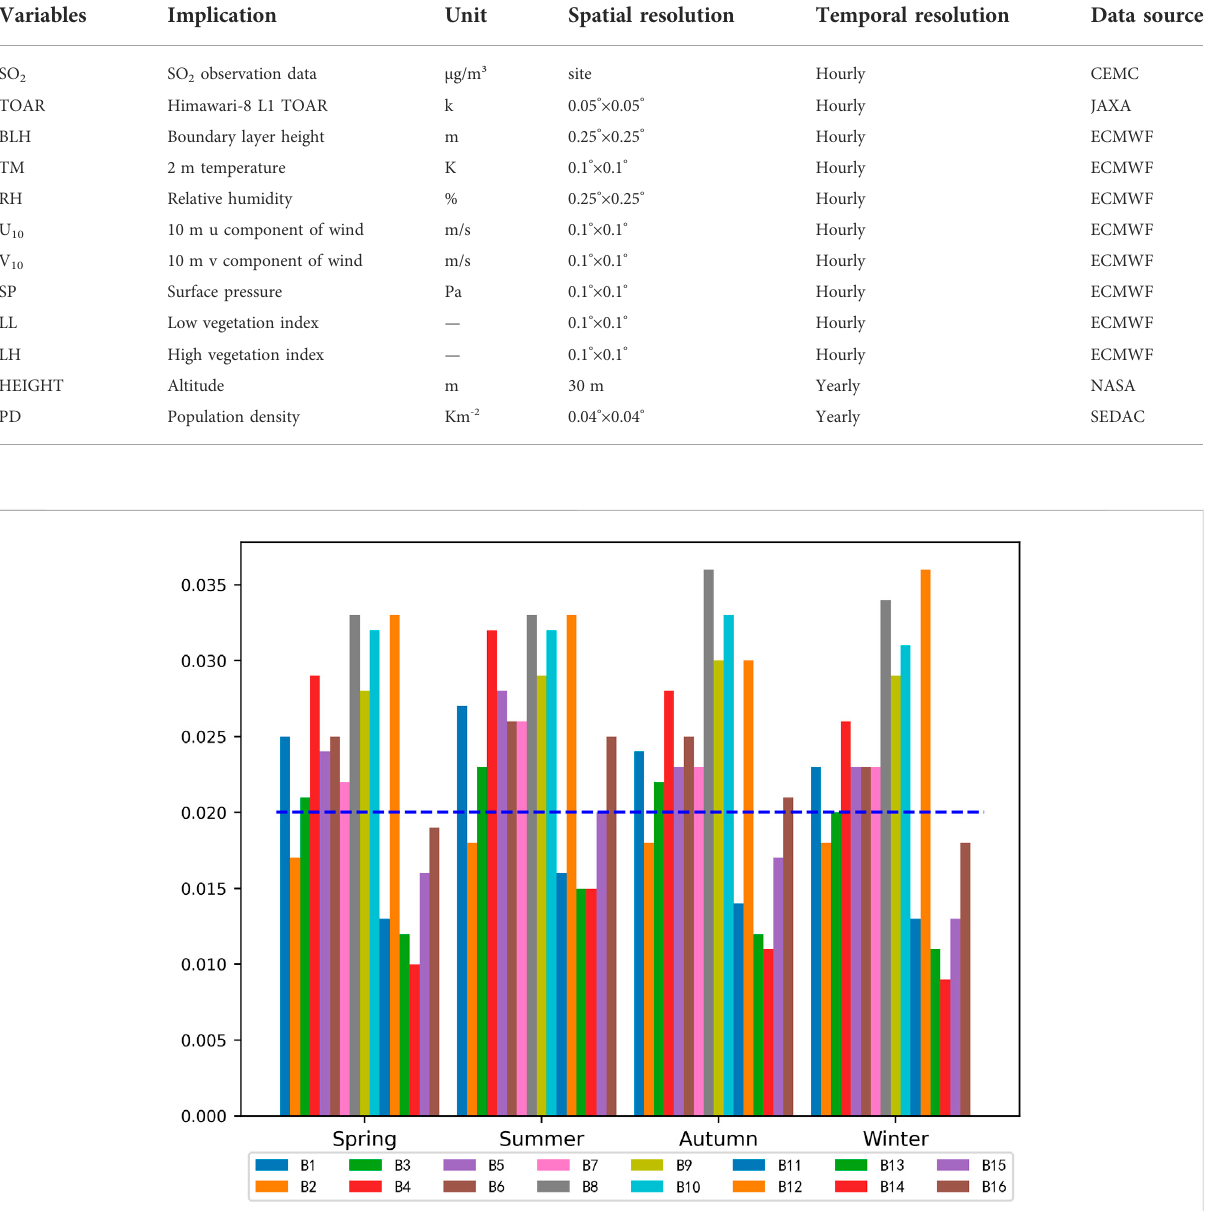
Frontiers in Earth